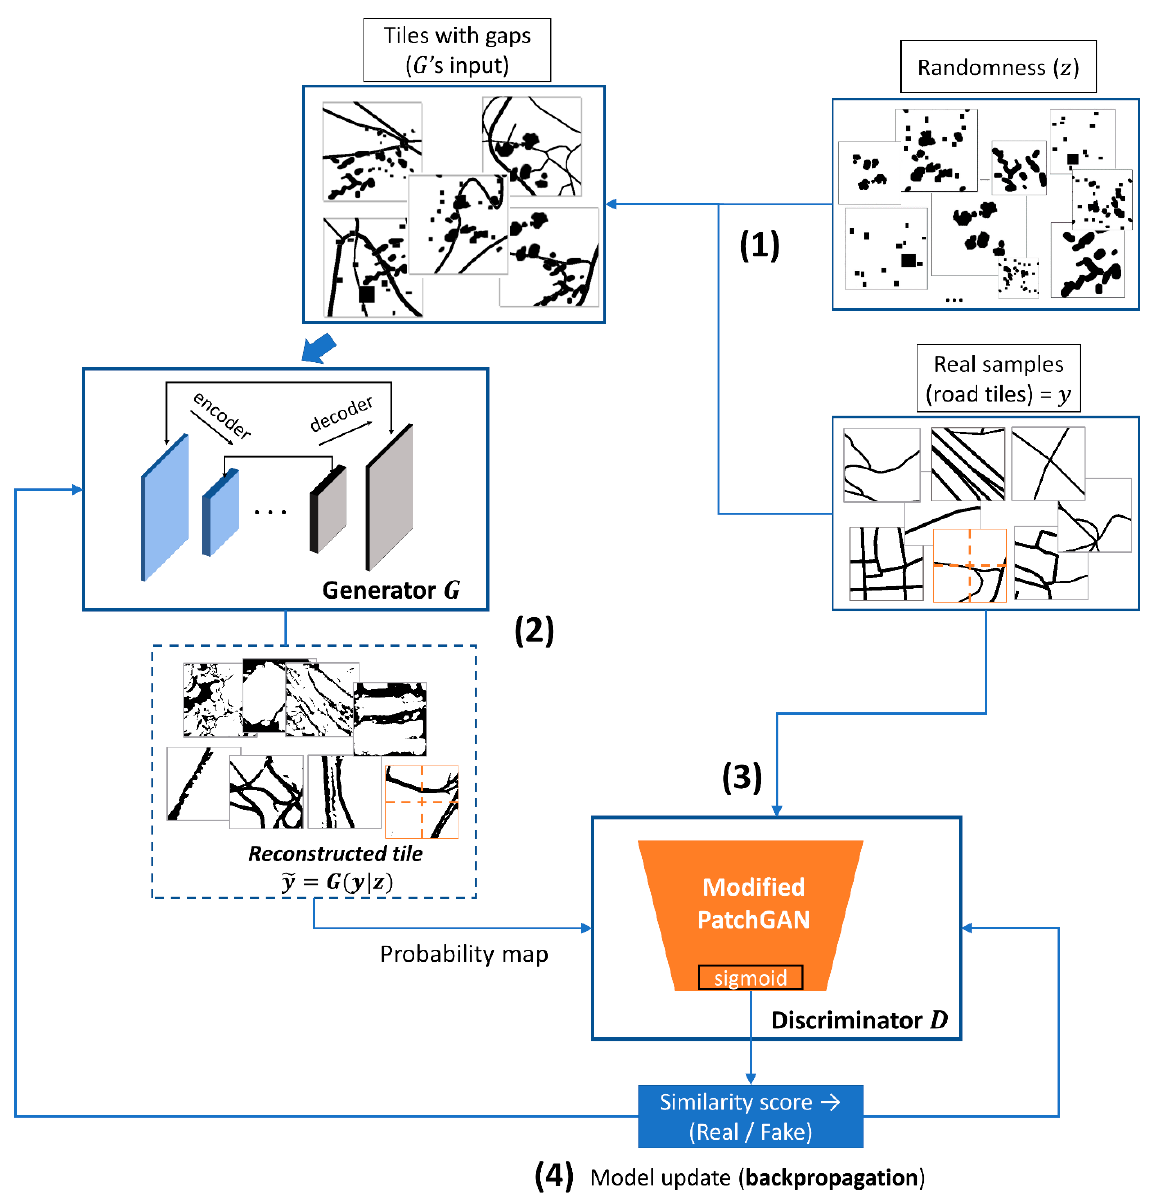
Figure 5. An overview of the learning process of the cGAN model trained for deep inpainting. ( 1 ) Firstly, random gaps are introduced into the conditional data, 𝑦 , to produce corrupted inputs for 𝐺 . ( 2 ) The generator (a U-Net-like network with skip connections) is then trained to fill the gaps and inpaint the corrupted tiles. ( 𝐺 does not have access to the real samples, 𝑦 , from the real data distribution, 𝑌 .) ( 3 ) The discriminator is a modified PatchGAN that classifies patches from pairs of y and 𝑦(cid:3556) and decides whether they come from the real data distribution, 𝑌 , or from the synthetic data distribution, 𝑌(cid:3560) . ( 4 ) 𝐺 receives feedback from 𝐷 and iteratively improves the synthetic data generator to “fool” the discriminator network. Notes: (A) The real data is fed both into 𝐺 (after adding z) and into 𝐷 . In our deep inpainting task, a sampled image, y , will be corrupted with randomness, z (in this case, random gaps of different sizes). 𝐺 will reconstruct this corrupted image and produce 𝑦(cid:3556) = 𝐺(𝑧|𝑦) . The synthetic results, 𝑦(cid:3556), will iteratively improve as 𝐺 receives feedback from 𝐷 . (B) The graphic should be interpreted at stage level and was created using random tiles to offer insights and enable a better understanding of the training procedure presented in Section 5.3.